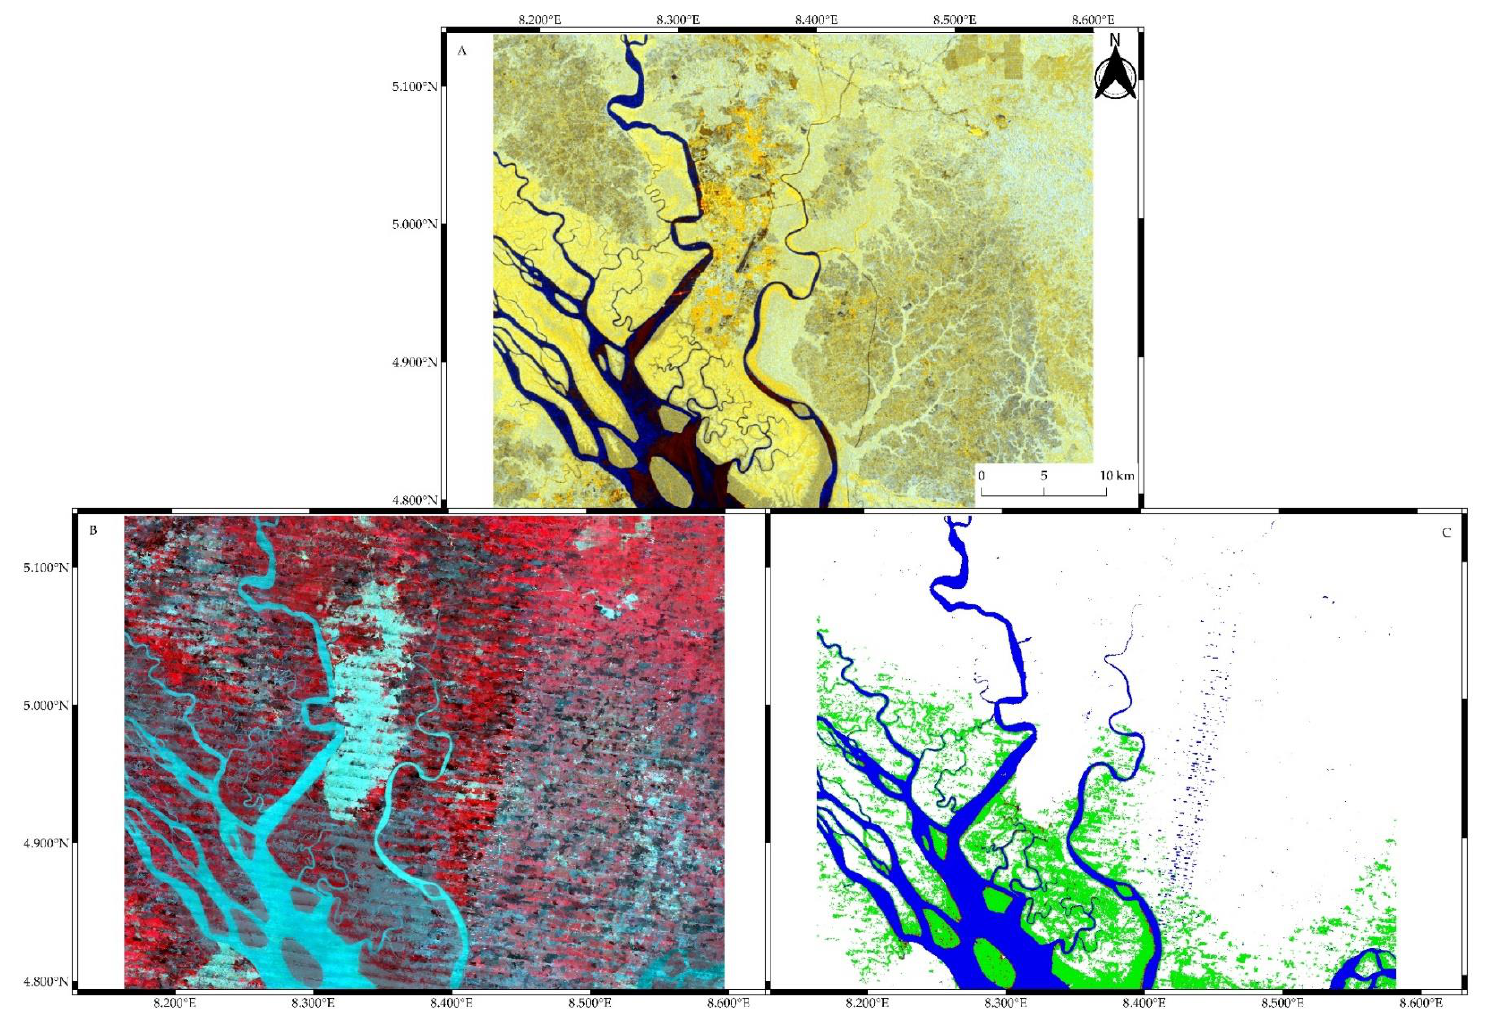
Figure 10 : Cloud cover limitation of Optical data over Kwa Ibo river southeastern Nigeria. ( A ) ALOS PALSAR radar scene; ( B ) classification imagery; ( C ) infrared scene.